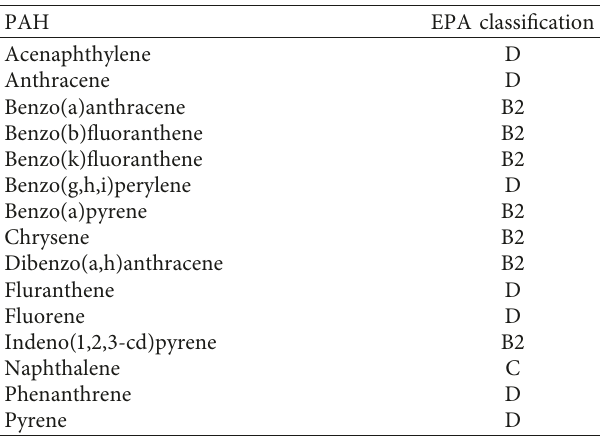
Figure 1: Chemical structure of the 16 PAHs listed in US EPA priority pollutants: (a) naphthalene; (b) acenaphthylene; (c) acenaphthene; (d) fluorene; (e) phenanthrene; (f) anthracene; (g) fluoranthene; (h) pyrene; (i) benzo(a)anthracene; (j) chrysene; (k) benzo(b)fluoranthene; Table 1: EPA classification of